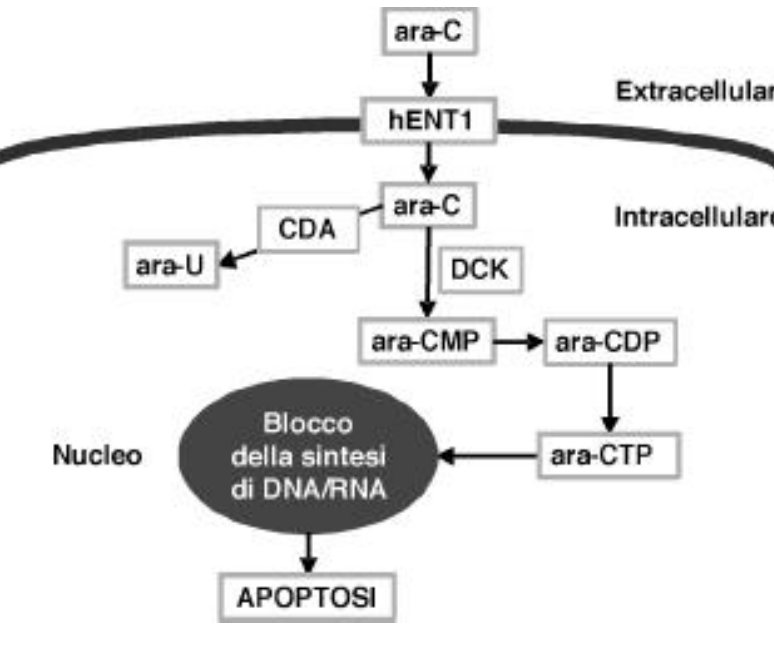
Figura 2. Trasporto intracellulare e metabolismo